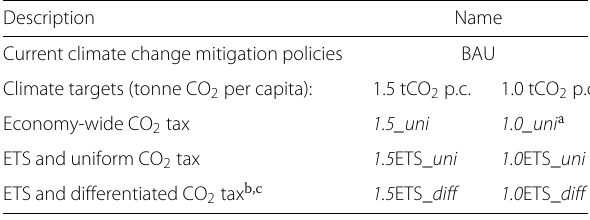
Table 3 Analyzed scenarios: climate goals and alternative policies